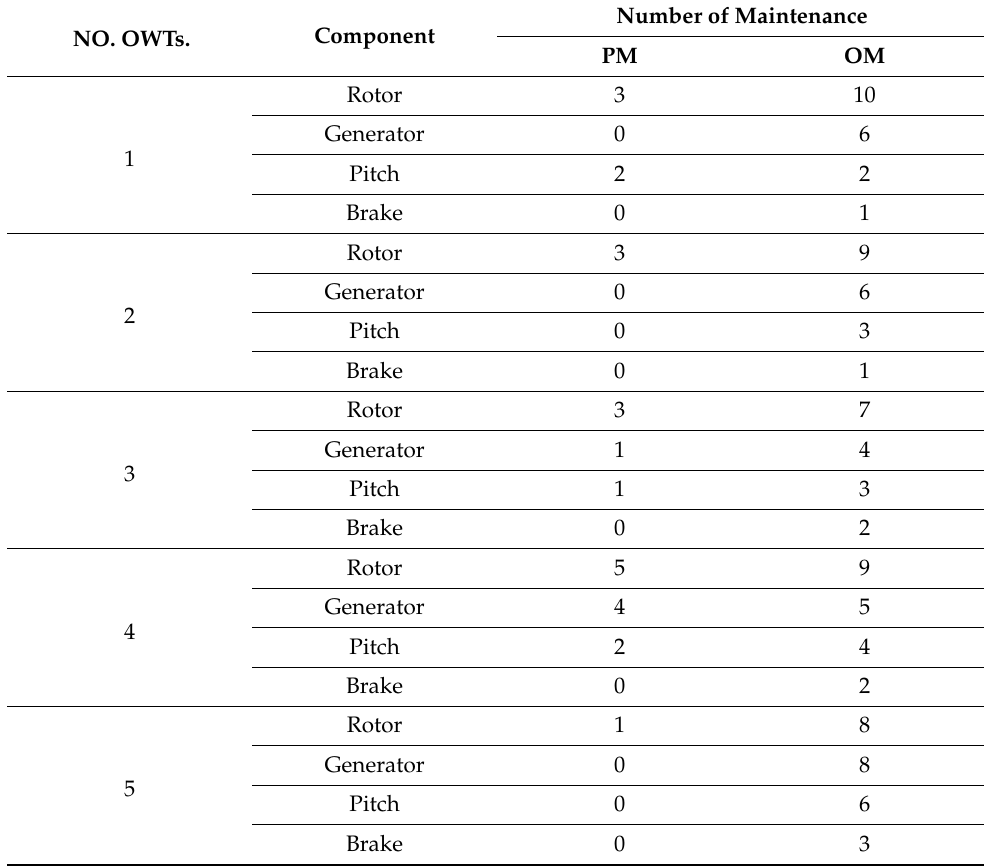
Table 5. The maintenance times of the main equipment for 5